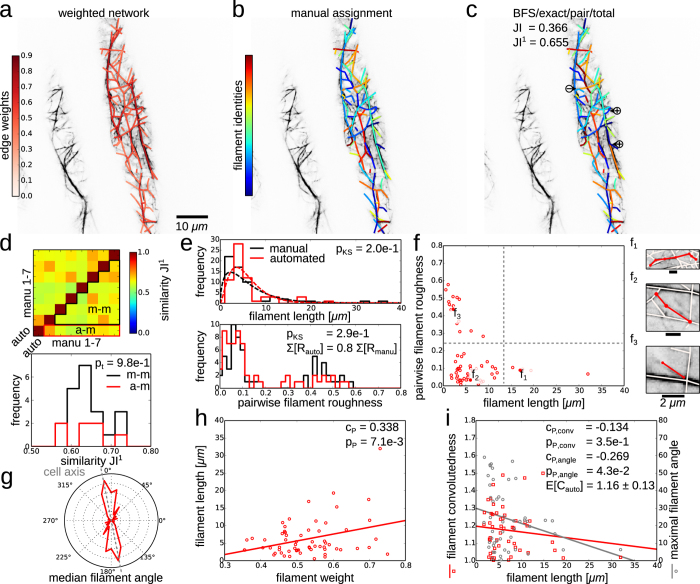
Filament covers and analyses of cytoskeletal network.The weighted cytoskeletal network is decomposed automatically by solving the exact FCP (exact) for paths from a modified breadth-first search (BFS) and by minimising the total (total) pairwise filament roughness (pair). (a) Overlay of confocal microscopy image of an actin cytoskeleton and extracted network with colour-coded edge weights. (b) Manual decomposition of the actin cytoskeleton into filaments with colour-coded indices. (c) The automated decomposition according to the FCP correctly assigns many of the filaments (JI1 = 0.655). Some occurrences of over- () and under-segmentation () are marked. (d) Heat map of similarity between automated (cf. (c)) and seven manual decompositions (cf. e.g. (b); upper panel). The similarities between automated and manual decompositions (red, denoted by a-m) do not differ from similarities among the different manual decompositions (black, m-m; lower panel; cf. independent two-sample Student’s t-test p-value pt ≥ 0.05). (e) Distribution of filament lengths for the manual (black) and automated solution (red) are similar (upper panel; cf. Kolmogorov-Smirnov test p-value pKS ≥ 0.05). Maximum likelihood fits of gamma functions are shown as dashed lines. The distributions of pairwise filament roughnesses are similar (lower panel; cf. p-value pKS ≥ 0.05), while the total roughness is smaller (cf. summed R-values) for the automated decomposition since it is minimised by the FCP. (f) Scatter plot of pairwise filament roughness versus filament length displays three regions, with representative examples f1 − f3 (solid dots): (f1) For long filaments (≥15μm), the roughness is moderate (<0.2), as expected for actin bundles; (f2) The majority of filaments is short (<15μm) and of moderate roughness; (f3) Some typically short filaments show a high roughness (≥ 0.2), namely those which are composed of one network edge only so that their roughness is given by the edge weight itself (cf. Eq. 1). (g) The distribution of median filament angles shows that the majority of filaments is aligned parallel to the cell axis (grey dashed line). (h) The filament length correlates with the filament weight (cf. linear regression and Pearson correlation coefficient cP > 0 and p-value pP < 0.05) (i) Scatter plot of filament convolutedness versus filament length shows a negative but non-significant correlation (cf. red squares, cP,conv < 0, and pP,conv ≥ 0.05) with an average convolutedness of E[C] = 1.16 ± 0.13. The maximum filament angle correlates negatively and significantly with the filament length (cf. grey circles, cP,angle < 0, and pP,angle < 0.05), indicating that longer (and thicker, cf. (g)) filaments are less curved.